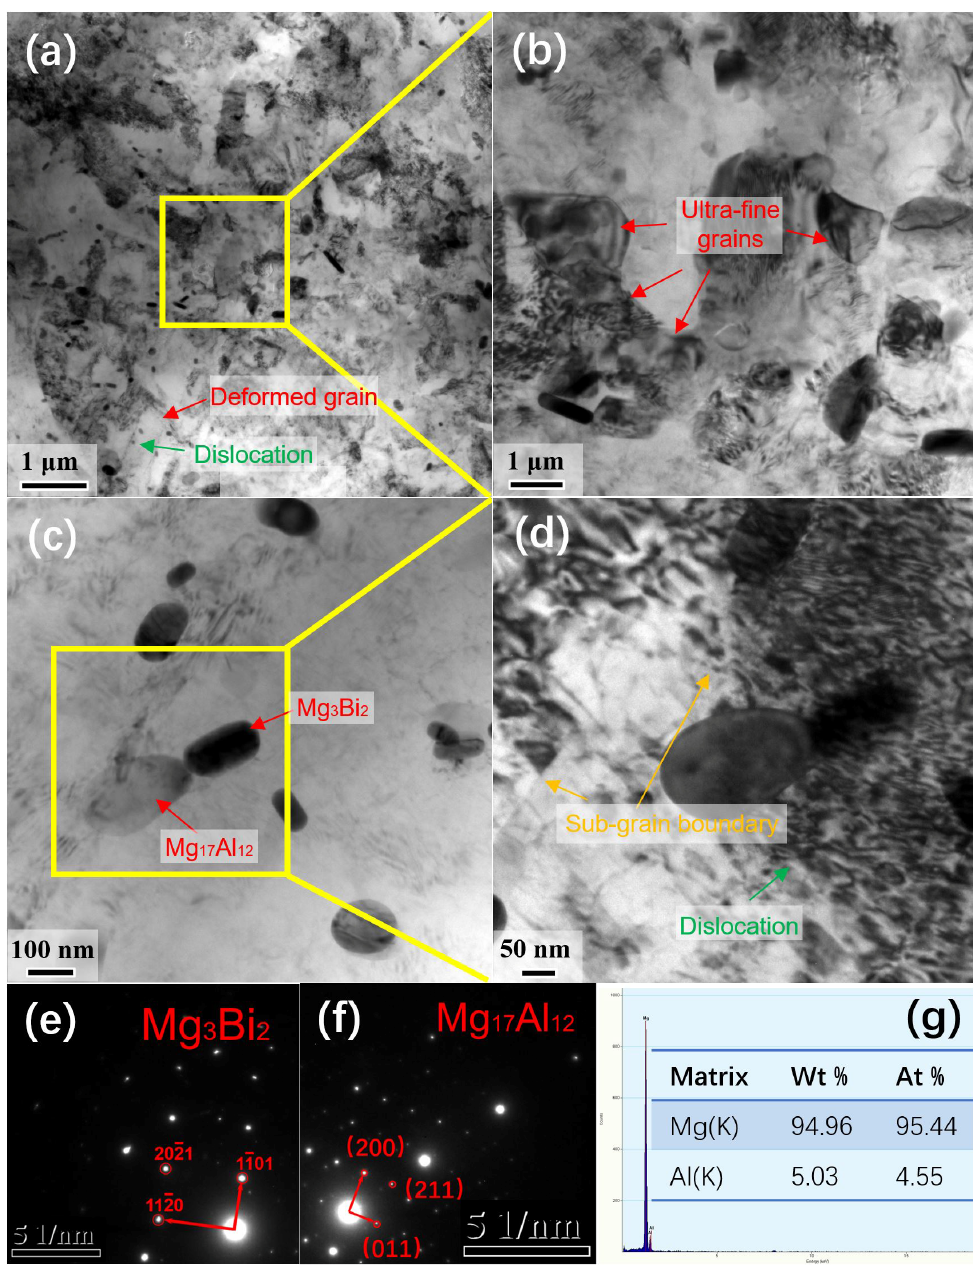
Figure 5. Bright-field transmission electron microscope (TEM) images ( a – d ), diffraction patterns of the selected areas ( e , f ), and ( g) energy-dispersive X-ray spectroscopy (EDX) results for the matrix of the caliber-rolled AB83 alloy.